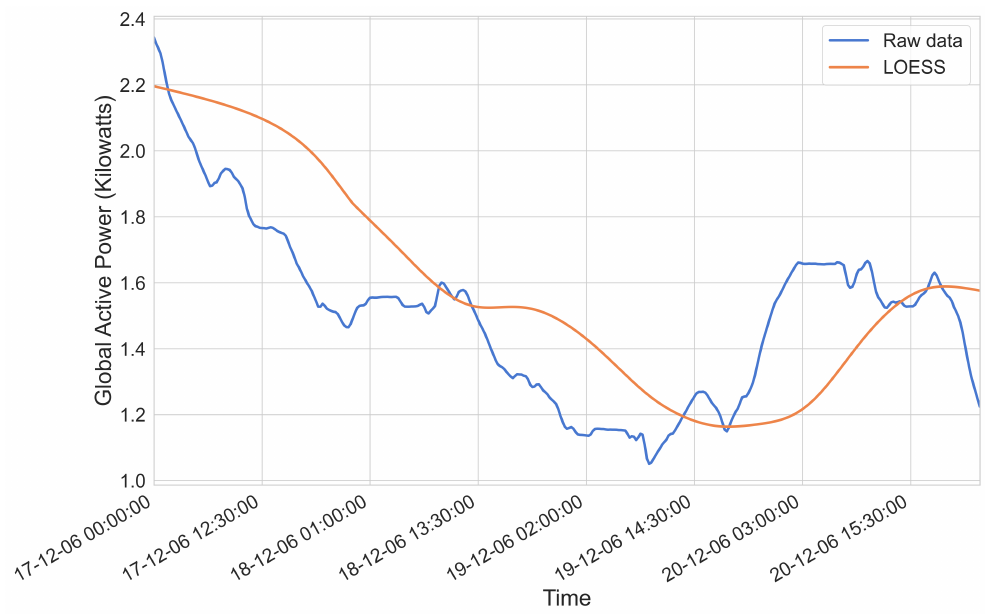
Figure 9. An illustration of the previously obtained trend component both with and without the application of